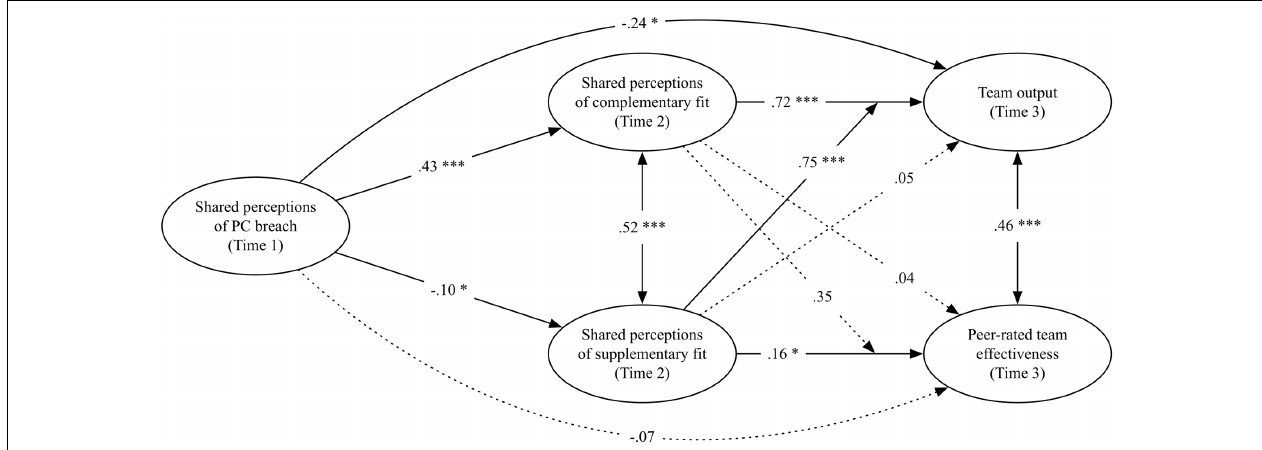
FIGURE 1 | Standardized estimated paths in the longitudinal three-wave autoregressive full moderated-mediation model. ∗ p < 0.05, ∗∗ p < 0.01, ∗∗∗ p < 0.001. Dotted lines indicate non-significant relationships. Double arrowed lines indicate correlations. Results indicate change in each variable by controlling for the auto-correlation at the previous moment in time. The relationships from shared perceptions of PC breach to team output and peer-rated team effectiveness are part of the partial moderated-mediation model and are presented as per reviewer’s